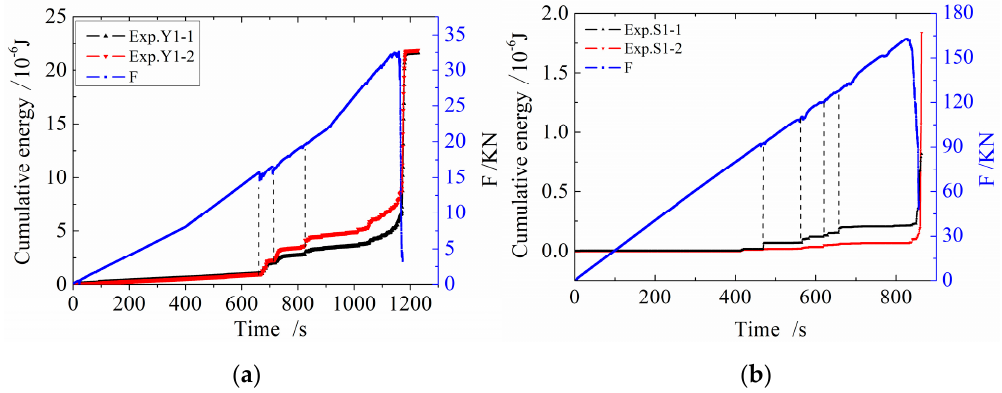
Figure 27. Accumulative value of MS signals and loading force (F) in experiments of raw coal and cement specimens. ( a ) Raw coal specimens and ( b ) cement specimens.